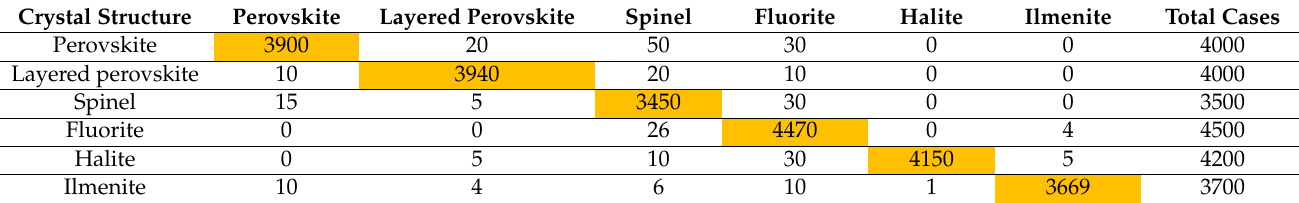
Table 7. Confusion matrix for the proposed PSP.